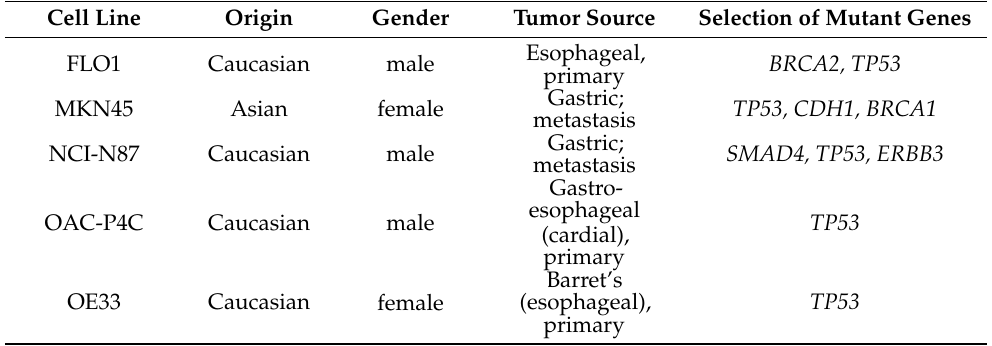
Table 1. Characteristics of used cell lines. Information was retrieved from public sources of ATCC, DSMZ, Cellosaurus and